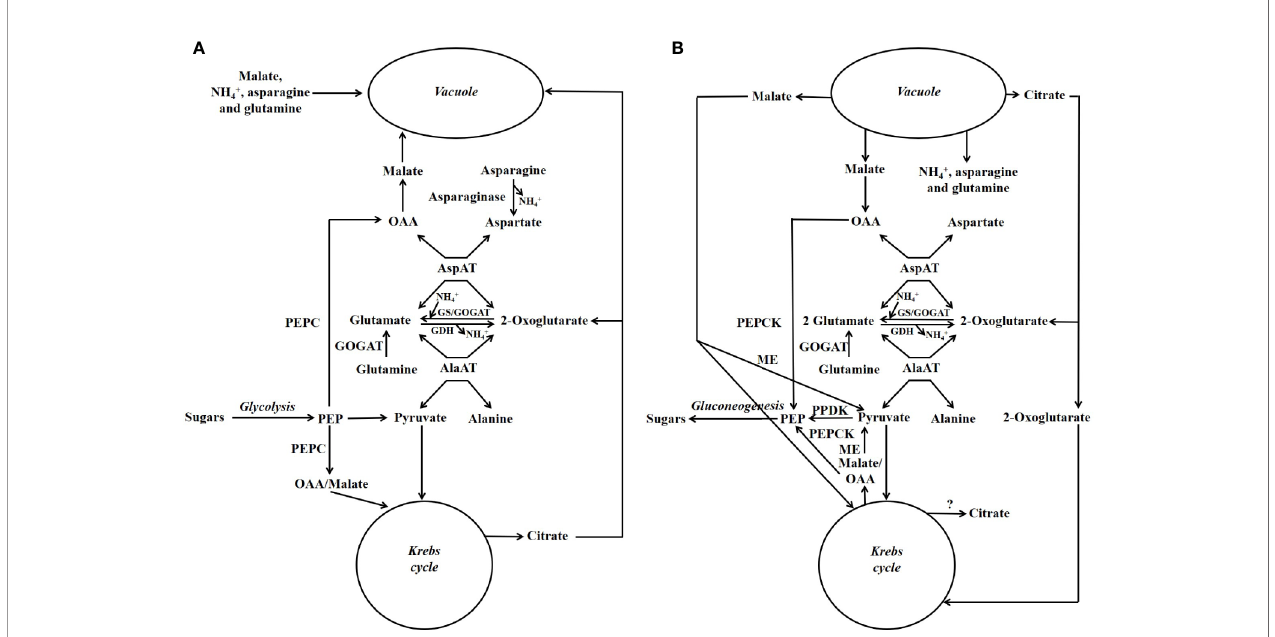
FIGURE 4 | Simpli fi ed scheme outlining the major pathways involved in the metabolism of nitrogenous compounds and malic and citric acids in fruits and seeds of stone fruits (based on Walker et al., 2018). Unlike in Figure 3 , the temporal organization of metabolism is taken into account. (A) Storage phase. (B) Utilization phase. GDH = glutamate dehydrogenase; GOGAT = glutamate synthase also known as glutamine oxoglutarate aminotransferase; GS = glutamine synthetase; ME = malic enzyme; OAA = oxalacetate; PEP = phosphoenolpyruvate; PEPC = phosphoenolpyruvate carboxylase; PEPCK = phosphoenolpyruvate carboxykinase; PPDK = pyruvate orthophosphate